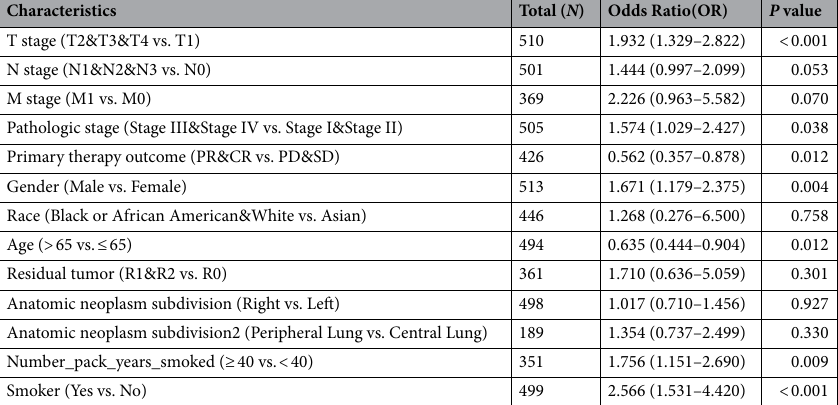
Table 2. NCAPH expression association with clinical pathological characteristics (logistic